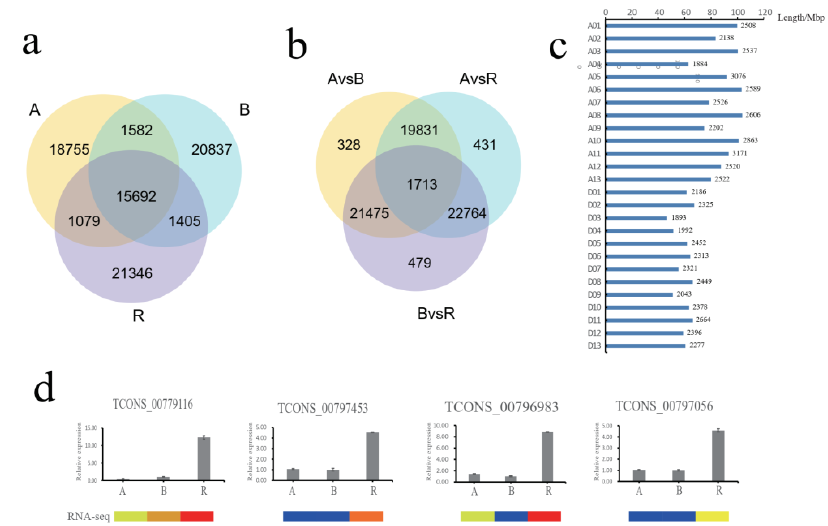
Figure 2. Venn diagram showing the common and distinct lncRNAs expression in A, B, and R lines. ( a ) The common and distinct lncRNAs identified in A, B, and R lines; ( b ) The common and distinct differentially expressed lncRNAs identified in A–B, A–R, and B–R comparison. ( c ) The distribution of